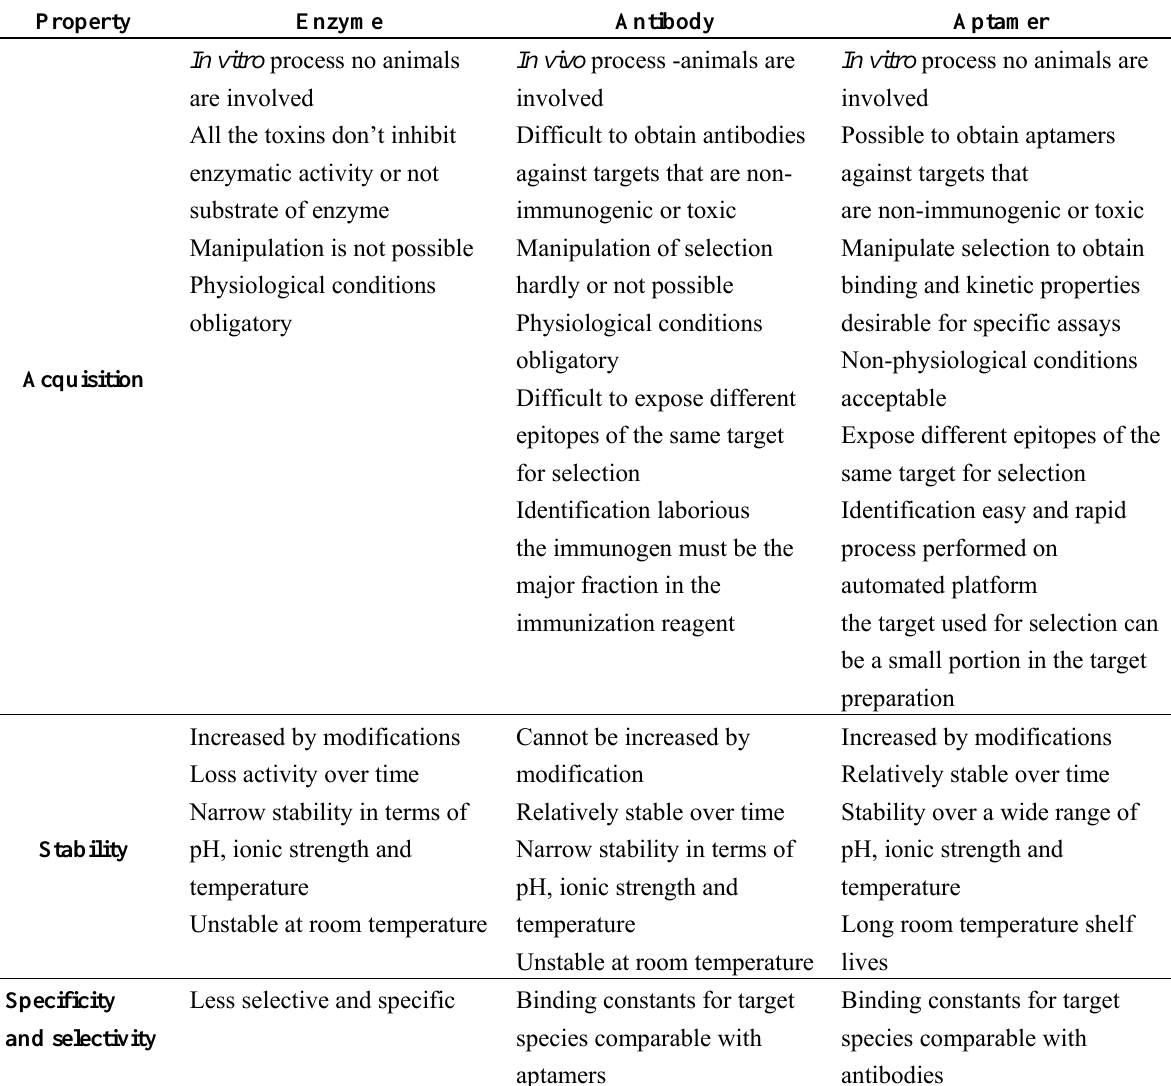
Table 1. Comparative study of the properties of the three commonly used biorecepters.